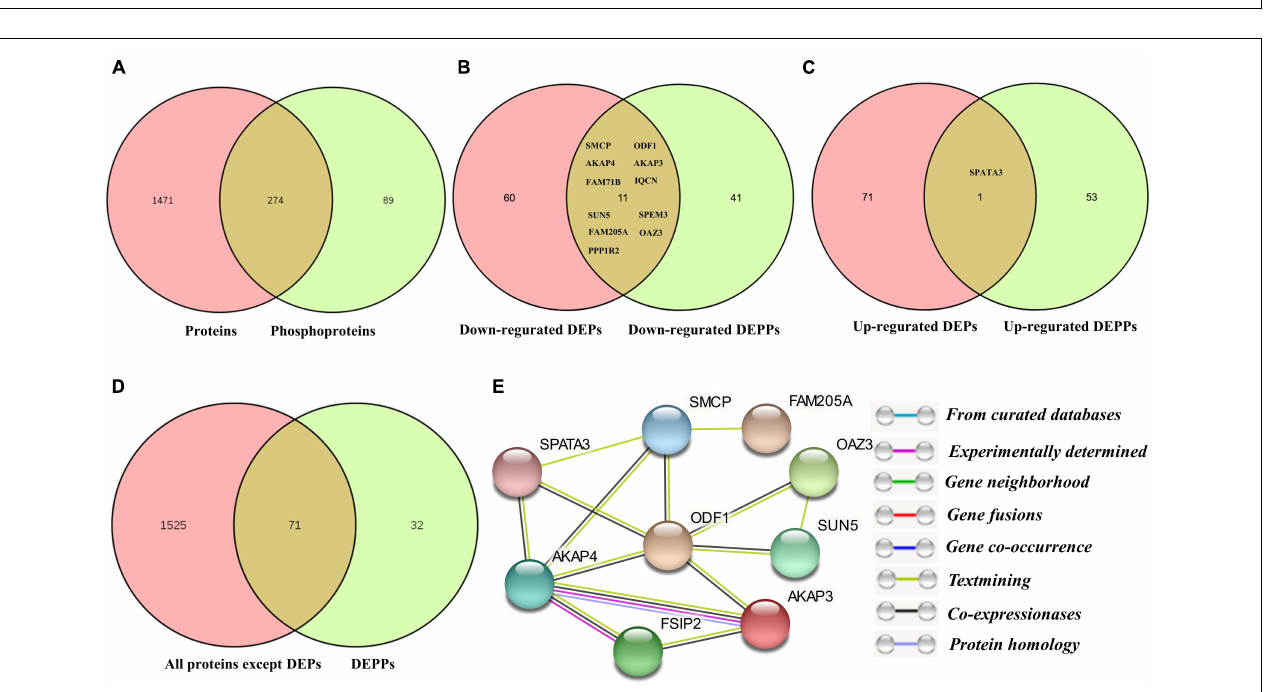
FIGURE 4 | The distribution and phosphorylation motif enrichment of the identified phosphorylation events. (A) The distribution of the phosphorylated serine (pS), threonine (pT), and tyrosine (pY) among the identified phosphorylation events. (B) The distribution of pS and pT sites of the differentially expressed phosphopeptides in boar sperm. (C) The Significantly enriched phosphorylation motif from all phosphorylation events. The height and color of the residues represent the frequency occurring at the respective positions and their physicochemical properties, respectively. Red arrow represents upregulated phosphosites, green arrow represents downregulated phosphosites, and asterisk represents that two or more phosphosites own the same the phosphorylation motif in the same protein.